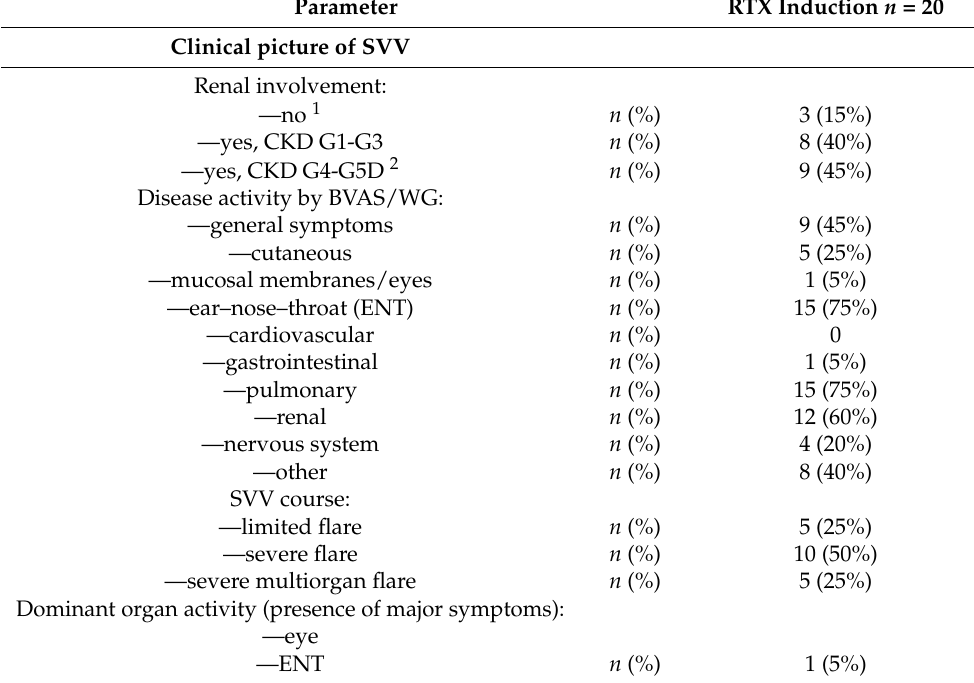
Table 2. Baseline characteristics of the study population (part